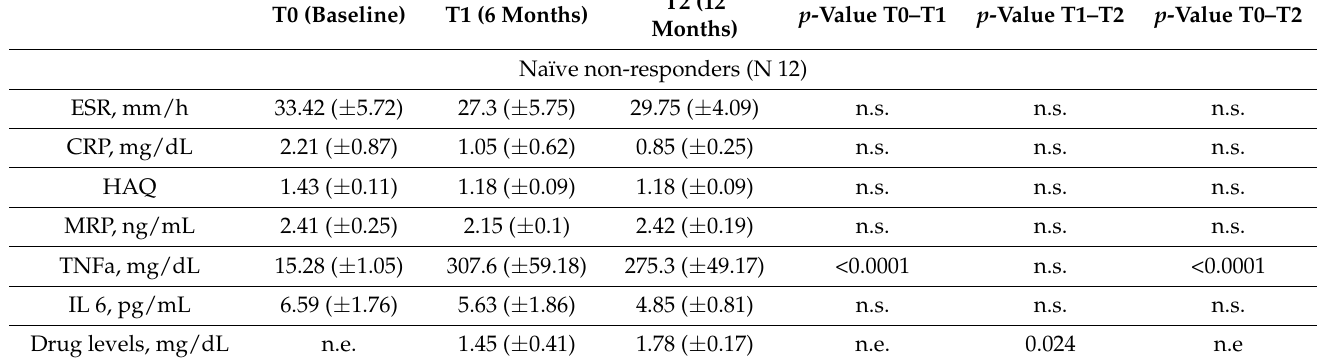
Figure 2. Levels of ETN in naïve patients and switcher responders and non-responders. The plus/star symbol (+) represent p -value = < 0.001.